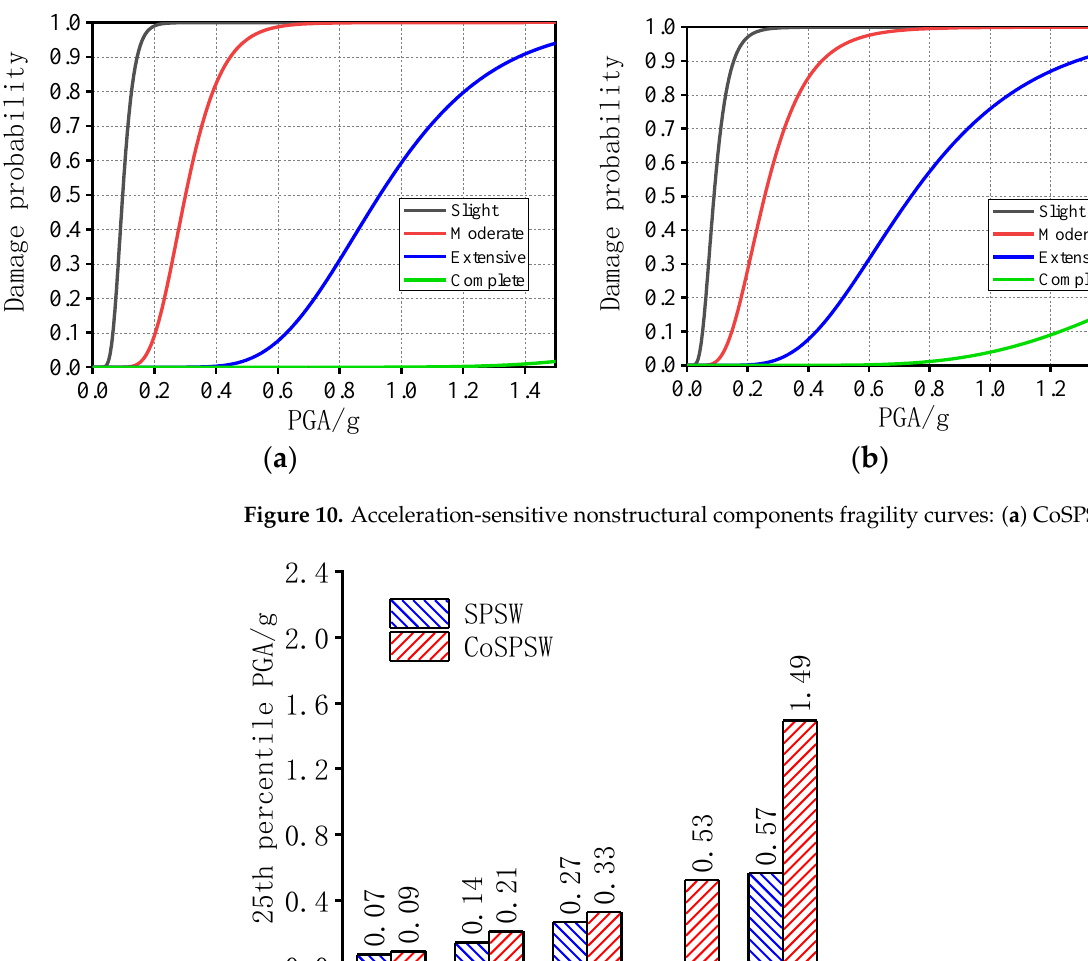
Figure 9. Drift-sensitive nonstructural components fragility curves: ( a ) CoSPSW, ( b ) SPSW.